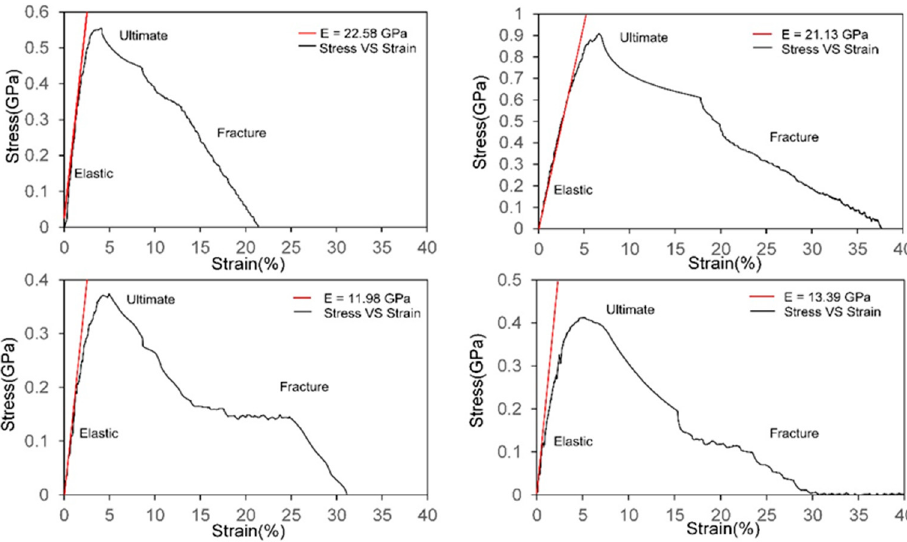
Figure 4 . Stress-strain curves. The curves are initial stress-strain curves generated by the Savitzky–Golay filter method on the basis of the huge amount of raw data points. To generate a smooth curve correctly representing the relationship between stress and strain, we use a cubic function to fit for every 50 data points. The red lines are linear fit for the elastic region, and its slope represents the stiffness. The value of stiffness is shown in the legend. ( a , b ) are stress-strain curves for chitin model pulling along inter-chain and inter-sheet directions, respectively; ( c , d ) are stress-curves for 85% chitosan model pulling along inter-chain and inter-sheet directions respectively. Table 1. Summary of stress-Strain behavior.